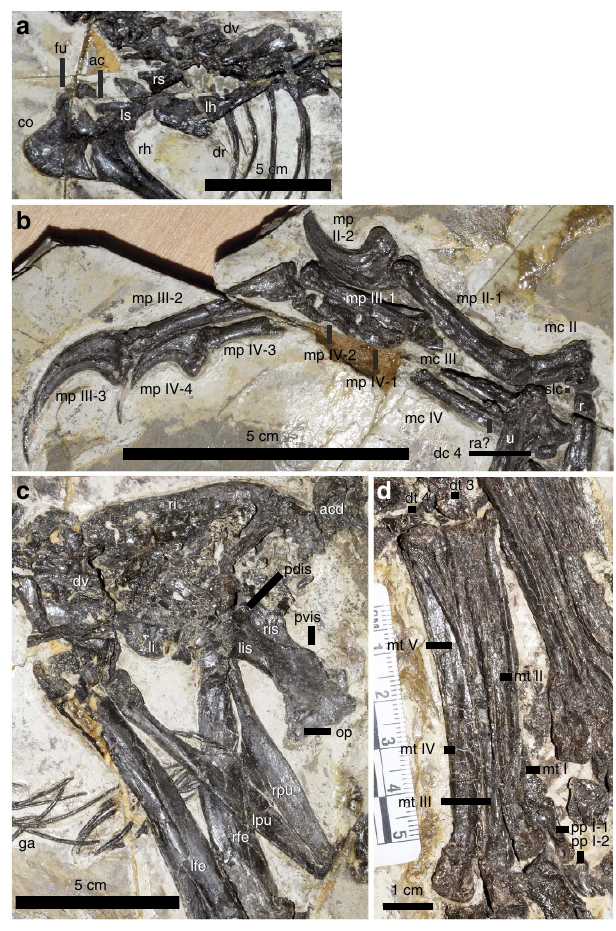
Figure 4 | Non-vertebral postcranial skeleton of Jianianhualong tengi holotype DLXH 1218. ( a ) Shoulder girdle, ( b ) right manus, ( c ) pelvis and ( d ) left pes. Scale bar, 5cm except in d , where it is 1cm instead. ac, acromial process; acd, anterior caudal vertebrae; co, coracoid; dc 4, distal carpal 4; dr, dorsal ribs; dt 3, distal tarsal 3; dt 4, distal tarsal 4; dv, dorsal vertebrae; fu, furcula; ga; gastralia; lfe, left femur; lh, left humerus; li, left ilium; lis, left ischium; lpu, left pubis; ls, left scapula; mc II to IV, metacarpals II to IV; mp II-1 to II-2, manual phalanges II-1 to II-2; mp III-1 to III-3, manual phalanges III-1 to III-3; mp IV-1 to IV-4, manual phalanges IV-1 to IV-4; mt I to V, metatarsals I to V; pp I-1 to I-2, pedal phalanges I-1 to I-2; pdis, dorsal posterior process of ischium; pvis; ventral posterior process of ischium; r, radius; ra?, radialae?; rfe, right femur; rh, right humerus; ri, right ilium; ris, right ischium; rpu, right pubis; rs, right scapula; slc, semi-lunate carpal; u,